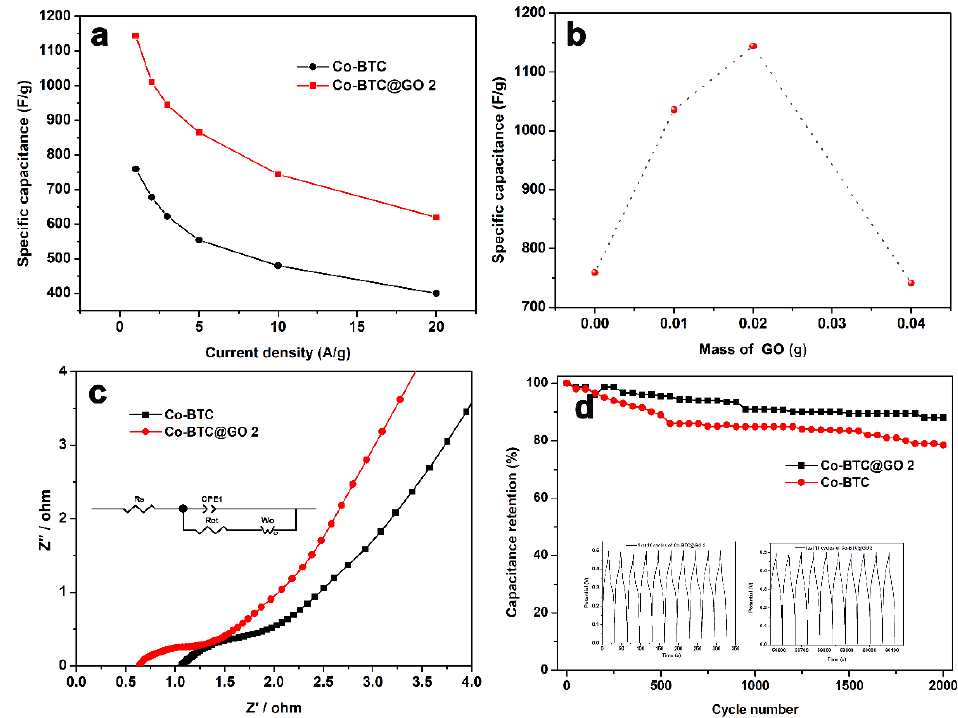
Figure 7. ( a ) The specific capacitance at various current densities for Co-BTC and Co-BTC@GO 2, ( b ) dependence of specific capacitance on the mass of GO at a current density of 1 A/g, ( c )